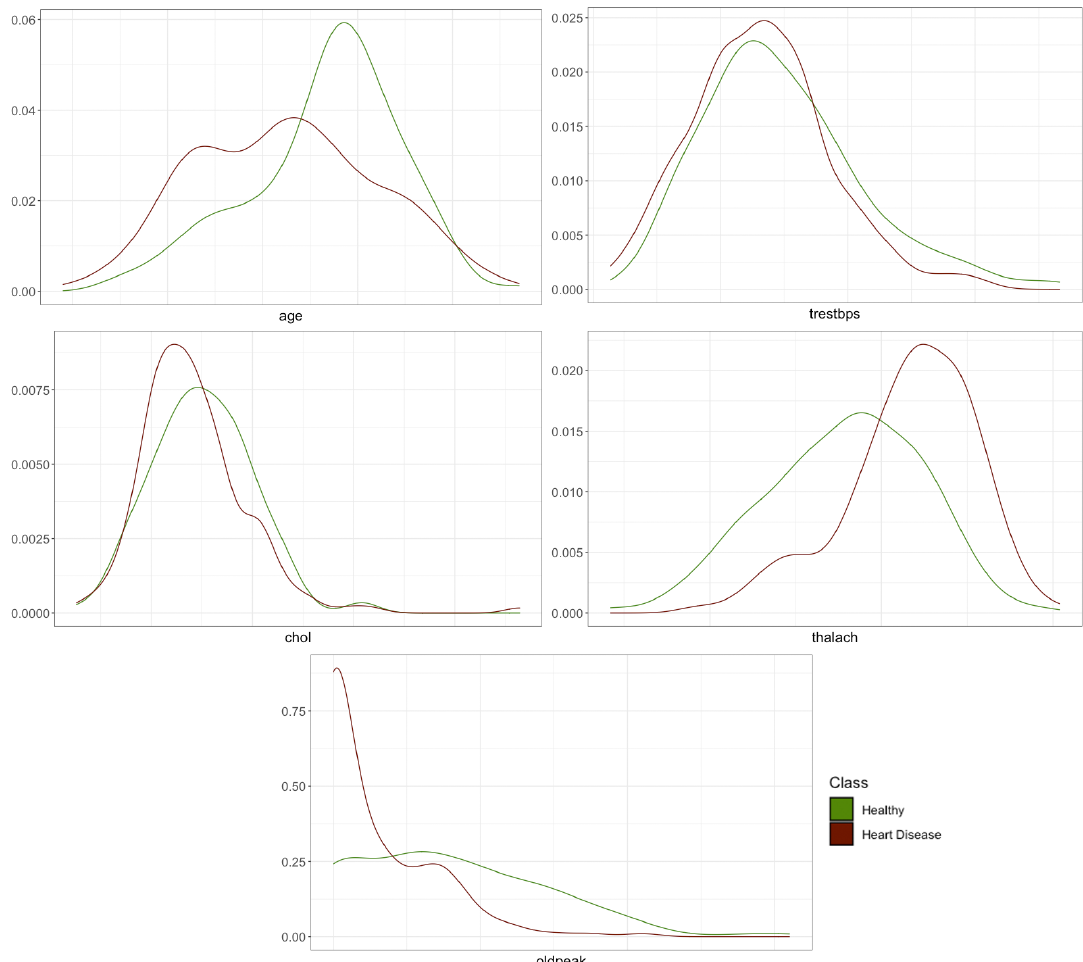
Figure 2. Density plots of numerical